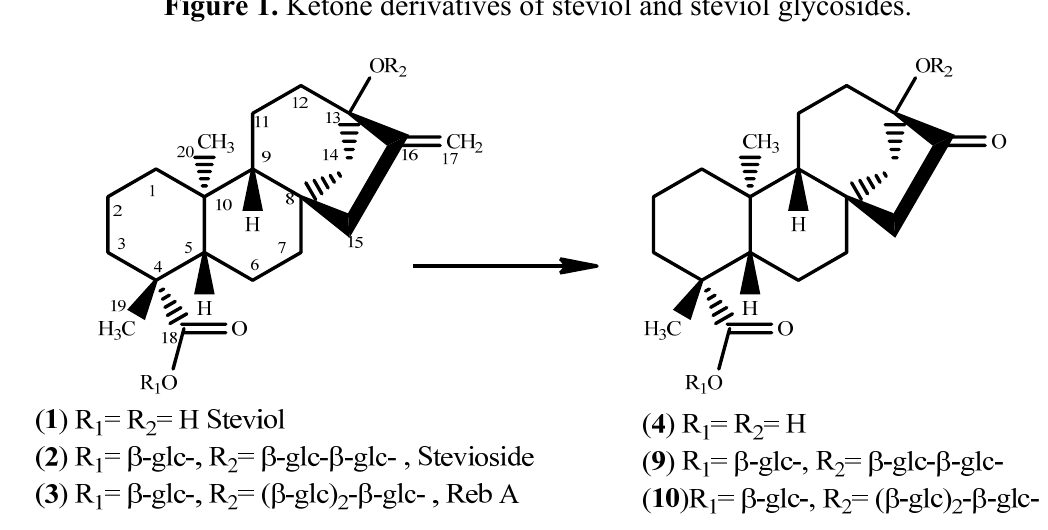
Figure 1. Ketone derivatives of steviol and steviol glycosides.